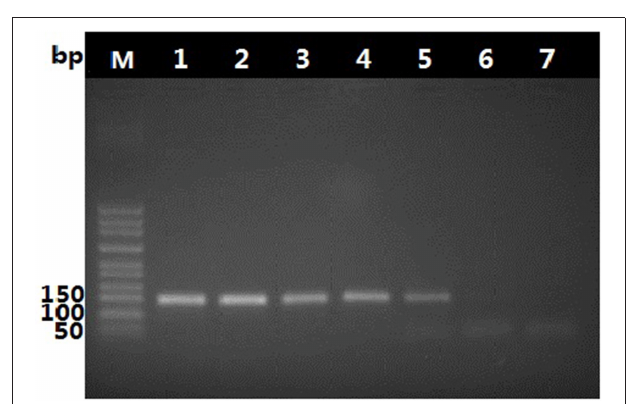
FIGURE 5 | Amplification products generated with primer pair, DCF4/DCR4, and decreasing amount of O. sinensis DNA. Lane 1–6: Products generated in a 25- µ L reaction mixture with ∼ 120, 60, 30, 15, 8, and 4 ng of O. sinensis DNA.